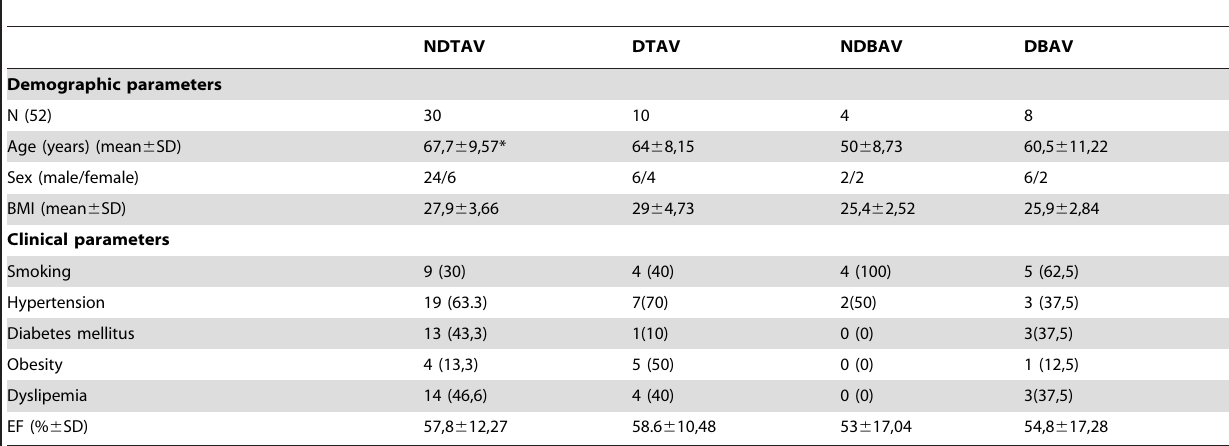
Table 1. Demographic and clinical characteristics of